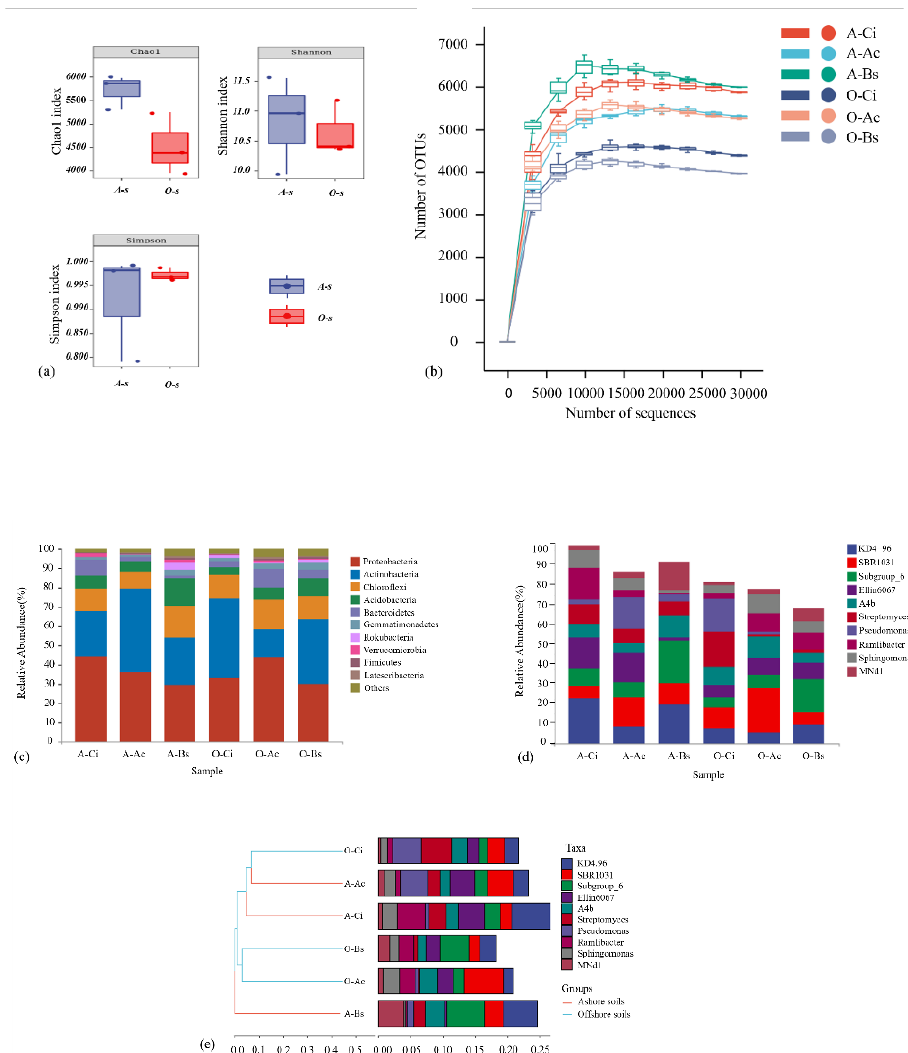
Figure 3. Soil microbial community structures and diversity. ( a ) Relative α -diversity for ashore and offshore soils; ( b ) rarefaction curves of detected bacterial operational taxonomic units (OTUs); ( c ) taxonomic composition analysis at the phylum level; and ( d ) taxonomic composition analysis at the genus level. O refers to the offshore soils while A refers to the ashore soils. At the same time, A-Ci, A-Ac, A-Bs, O-Ci, O-Ac, and O-Bs, respectively, refer to Ashore- Canna indica , Ashore- Acorus calamus , Ashore-bulk soil, Offshore- Canna indica , Offshore- Acorus calamus , and Offshore-bulk soil; ( e ) hierarchical clustering analysis of different samples, A-Ci, A-Ac, A-Bs, O-Ci, O-Ac, and O-Bs, respectively, refer to Ashore- Canna indica , Ashore- Acorus calamus , Ashore-bulk soil, Offshore- Canna indica , Offshore- Acorus calamus , and Offshore-bulk soil.